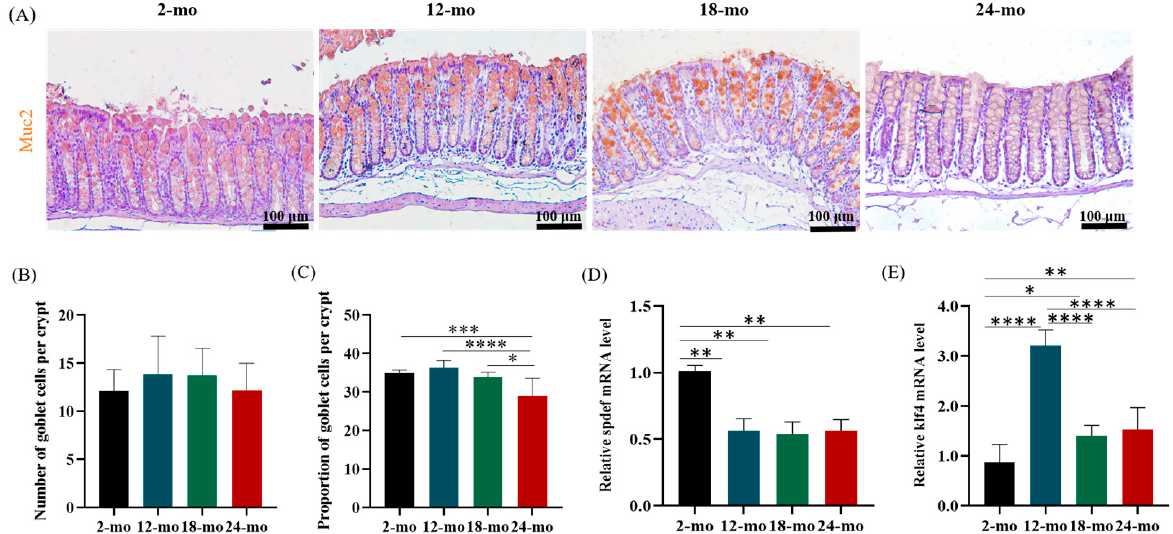
Figure 5. The number and proportion of goblet cells and the expression of genes regulating goblet cell formation changed in aging mice. Immunohistochemical staining of 2-, 12-, 18- and 24-month- old mouse colon sections with anti-Muc2 (in brown; cell nuclei in blue) ( A ), Scale bars: 100 µ m. Number ( B ) and proportion ( C ) of goblet cells were measured. Relative mRNA expression of spdef ( D ) and klf4 ( E ) in the colon of mice. Data were presented as mean ± SD. Data were statistically analyzed using one-way ANOVA with Tukey’s post hoc test. Asterisk indicates significant difference, * p < 0.05, ** p < 0.01, *** p < 0.001, **** p < 0.0001, n = 3 per group.